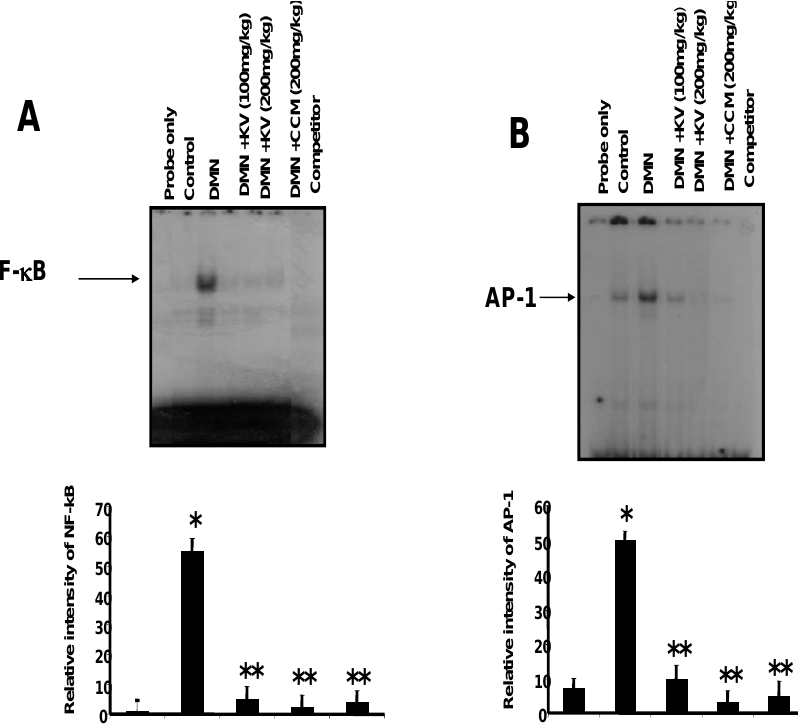
Lane 1, free probe; lane 2, control; lane 3, DMN alone; lane 4, kolaviron (100 mg/kg) plus DMN; lane 5, kolaviron (200 mg/kg) plus DMN; lane 6, curcumin (200 mg/kg) plus DMN; lane 7, competitor. * P < 0.001 compared with lane 2; ** P < 0.001 compared with lane